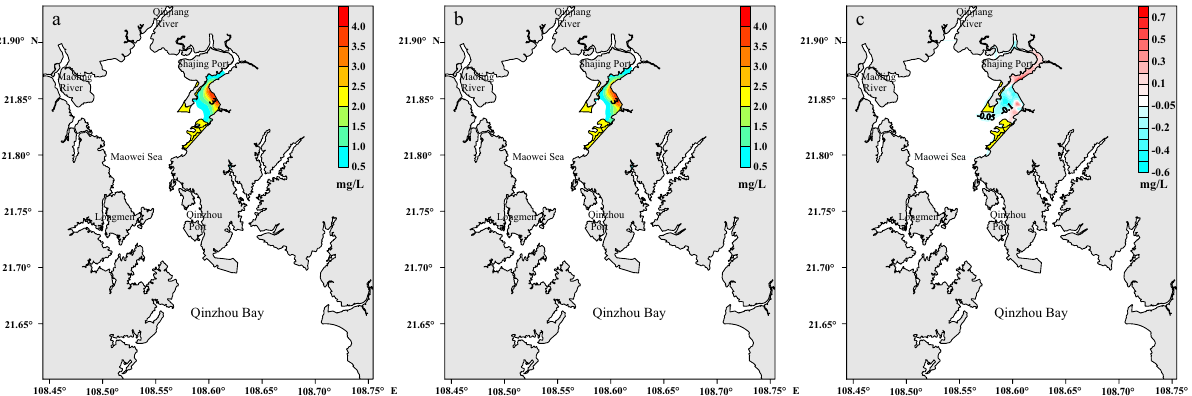
Figure 7. Distributions of COD concentration in the Industrial Park before the project (a) , after the project (b) and its variation after project (c) . These figures were drawn with Surfer10 Software (https:// www. golde nsoft ware. com/ produ cts/